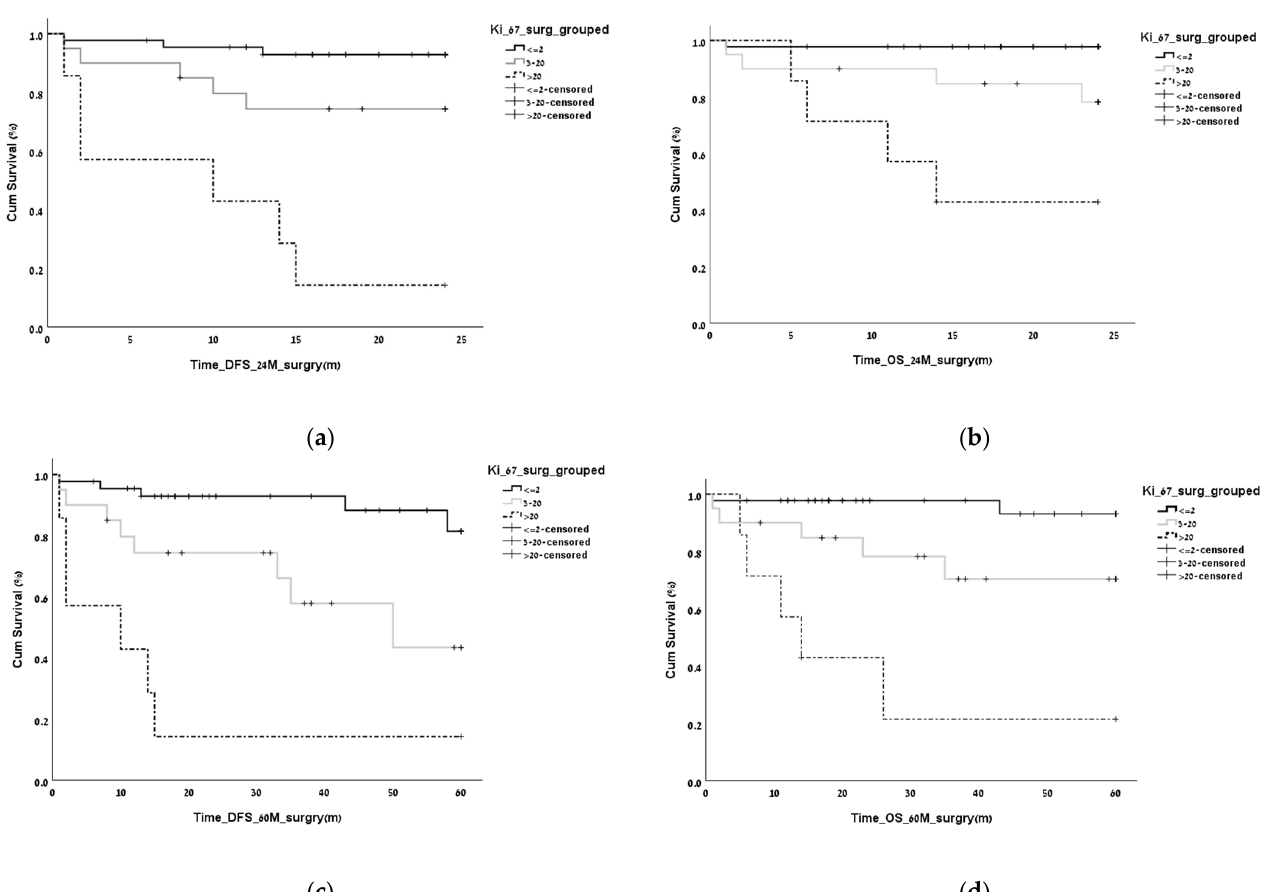
Figure 1. Overall survival (OS) and disease-free survival (DFS) of the entire cohort at 2 and 5 years. OS and DFS at 2 years postoperatively ( a,b ) and after 5 years postoperatively ( c,d ). Tumor grade significantly affected the DFS and the OS at 2 and 5 years, and the effect was preserved after adjustment for the selected variables (vascular invasion, smoking di- abetes, age, sex, metastatic disease at diagnosis, and adjuvant therapy) (Figure 2). No cut- off for positive LNs was found to have a significant effect on either DFS or OS.